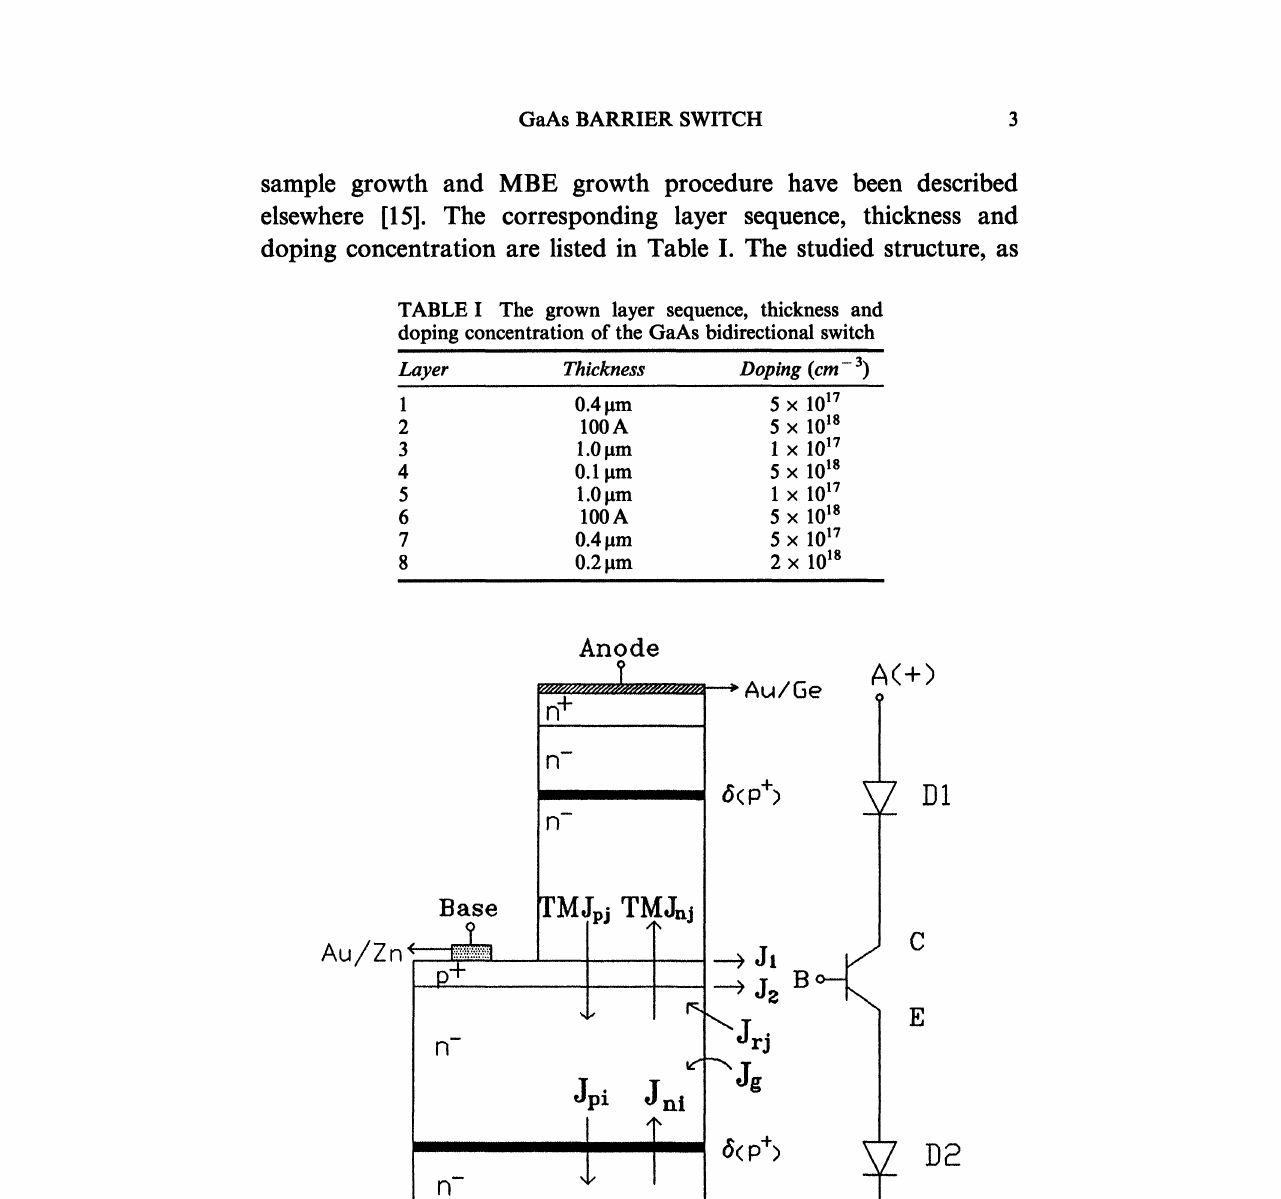
FIGURE (a) Schematic cross section of the proposed bidirectional switch and relative current components. (b) The equivalent circuit of the studied